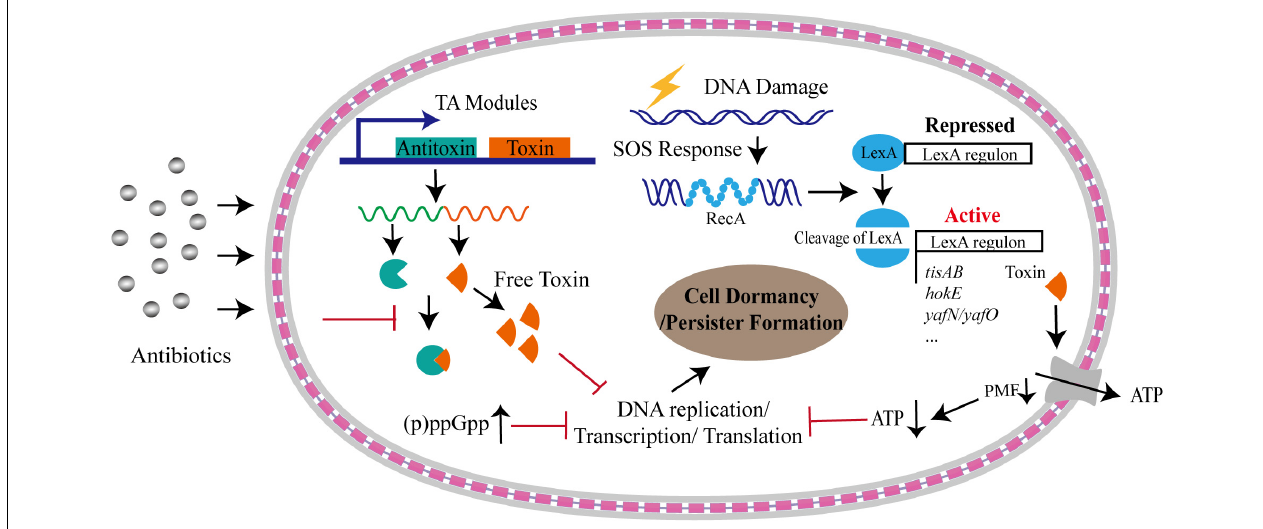
FIGURE 1 | Formation of bacterial persistence via cell dormancy. Various pathways could trigger bacterial cells into dormant state upon antibiotic stress. A considerable number of TA modules could free toxins upon stresses, which result in persister formation by inhibiting DNA replication, or transcription, or translation processes, or downregulating proton motive force (PMF) that is under the control of SOS response. Dormancy could be also triggered by accumulated alarmone molecules and decreased intracellular ATP levels. The gray layers represent the outer membrane and inner membrane, respectively, and the red square linkage represents the peptidoglycan and periplasmic